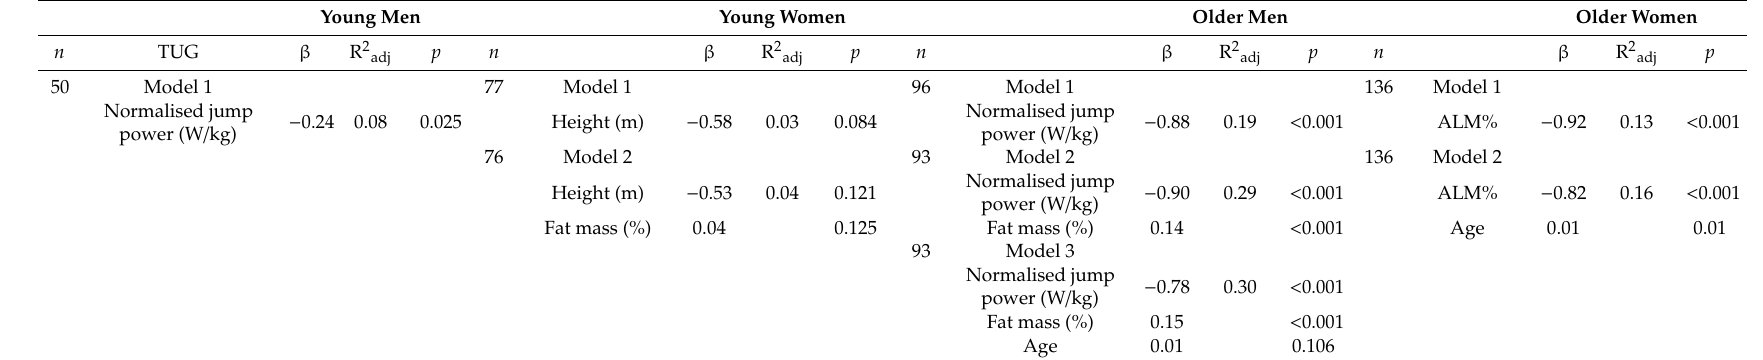
Table 3. Parsimonious multivariate regression models with the timed up-and-go test as the dependent variable and body composition and physiological variables as independent variables.